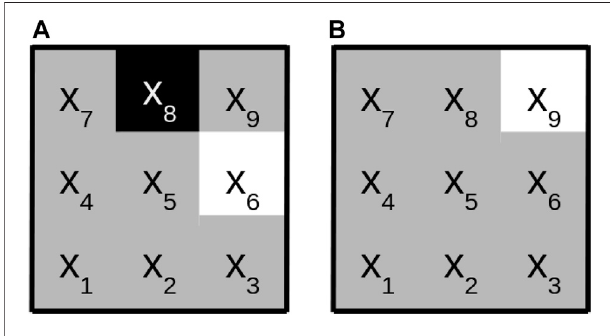
FIGURE 1 | Graphical representation of the logical formula P ( 1 ) conv ( x ) ∨ P ( 2 ) conv ( x ) , where P ( 1 ) conv ( x ) : (cid:2) {( x 1 , ... , x m )| x 6 ∧ − x 8 istrue } and P ( 2 ) conv : (cid:2) {( x 1 , ... , x m )| x 9 istrue } . The fi rst convolutional predicate is displayed on the (A) , the second one on the (B) . Variables which have to be true in order for the predicate to evaluate to true are marked white. Variables which have tobefalseinorderforthepredicate toevaluate totruearemarkedblack. Variables that have no in fl uence on the evaluation are marked